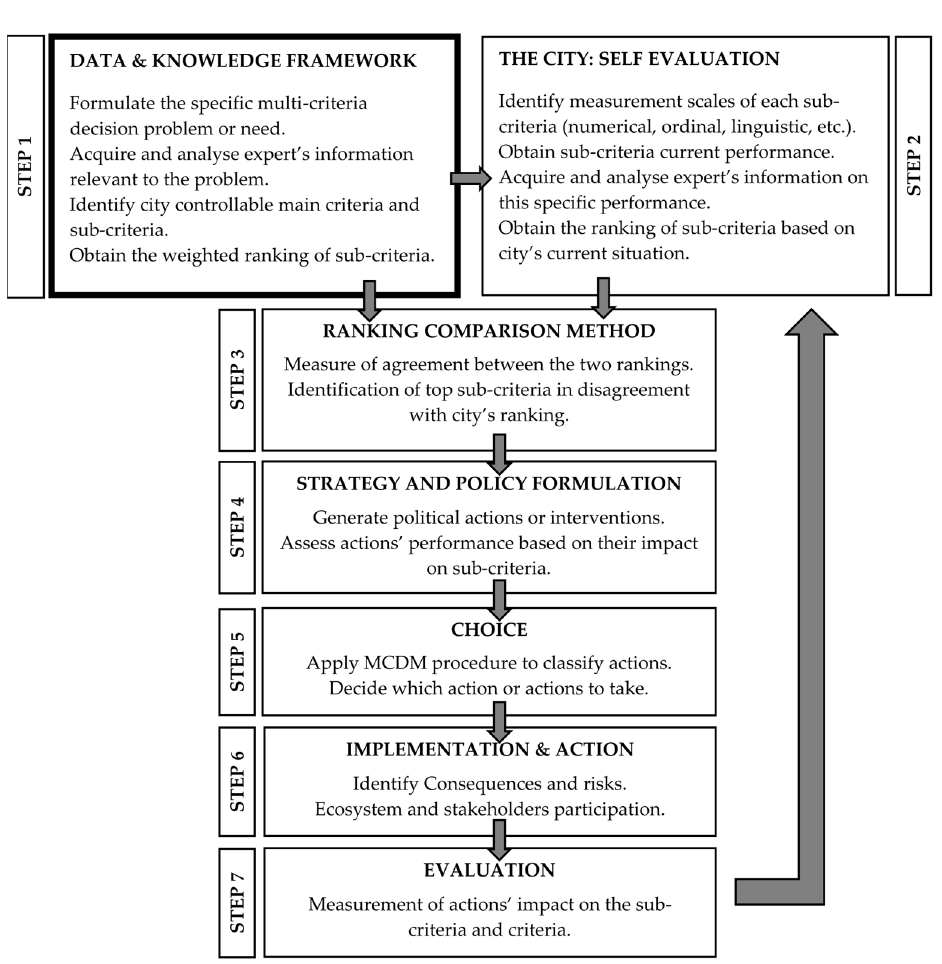
Figure 1. Holistic plan to help city leaders move from the theoretical framework to actions.